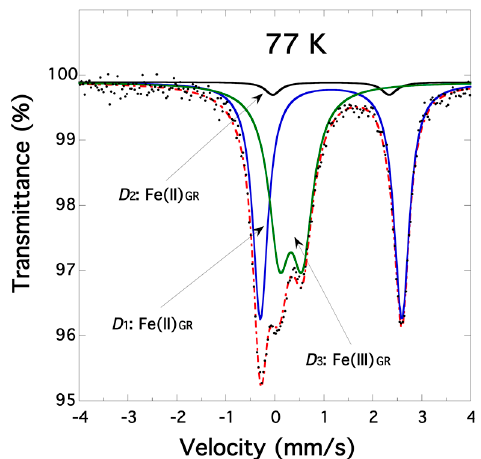
Figure 2. Transmission Mössbauer spectrum for biogenic hydroxycarbonate green rust recorded at 77 K. Experimental and fit curves are displayed as dotted black and dashed red lines, respectively. The fit components displayed as plain lines correspond to three doublets D 1 , D 2 and D 3 .